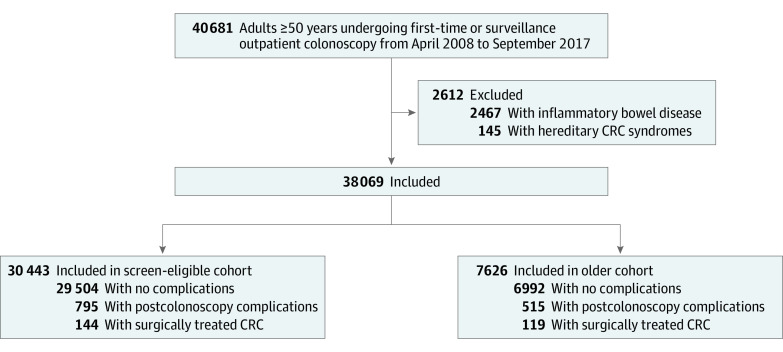
Selection of Study PopulationCRC indicates colorectal cancer.